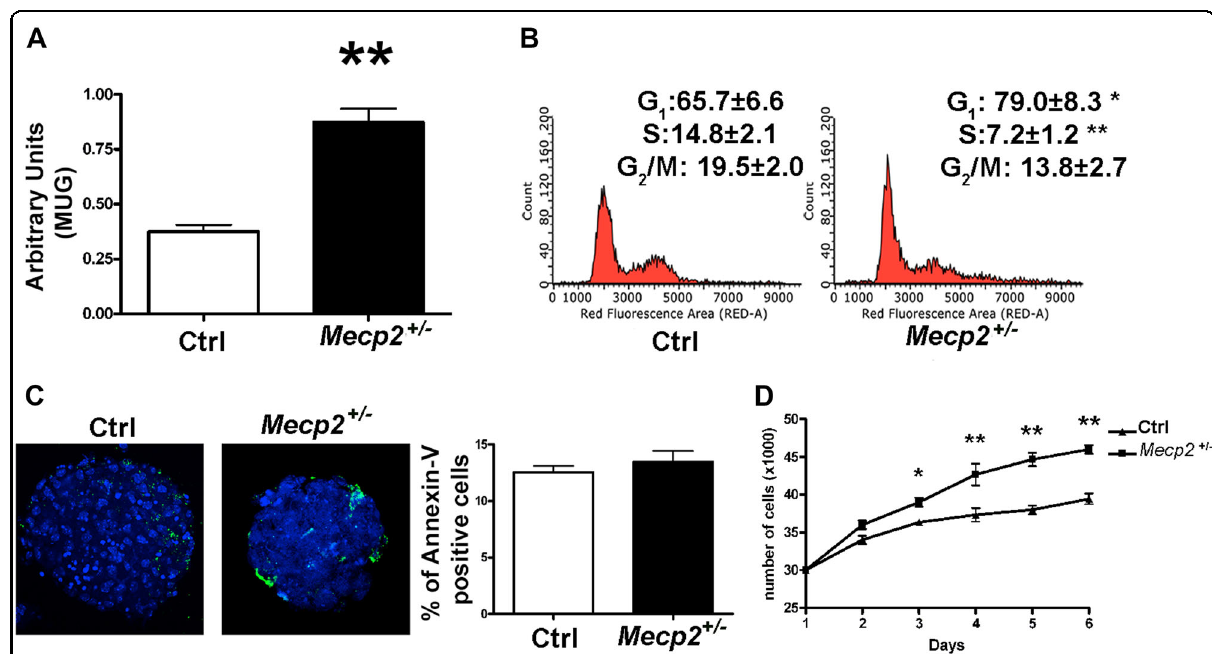
Fig. 1 Cell growth, senescence, and apoptosis assays on Mecp2 + / − and control NSCs. a Senescence evaluation was performed with the MUG assay. The data are expressed as arbitrary units (±SD, n = 5 biological replicates, ** p < 0.01). b Cell cycle analysis. The picture shows the cell cycle pro fi les of mutated and control NSCs (±SD, n = 5 biological replicates, * p < 0.05, ** p < 0.01). c Annexin V assay to detect apoptotic cells. Representative photomicrographs of apoptotic cells stained with Annexin V (green). Nuclei were counterstained with Hoechst 33342 (blue). Graph shows mean expression values in Mecp2 + / − and control samples (±SD, n = 5 biological replicates). d Cell proliferation was determined with a Quick Cell Proliferation Assay Kit II. Cells were seeded in 96-well culture plates. At 2, 3, 4, 5, and 8 days post plating, the cells were collected and counted (±SD, n = 5 biological replicates, * p < 0.05, ** p <